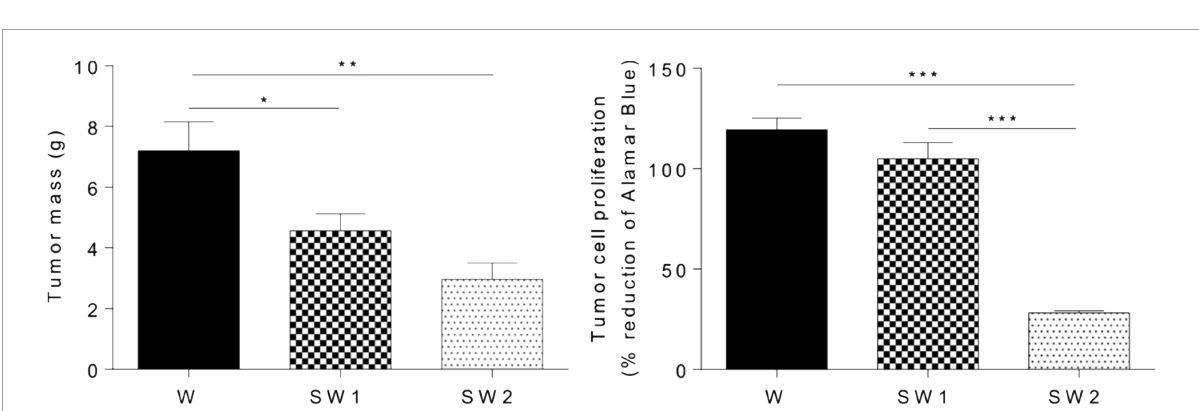
FIGURE15 Effect of latex treatment on tumor mass and tumor cell proliferation in untreated animals with tumor (W), animals with tumor treated with 25 µ L/mL aqueous solution of latex (SW1), and animals with tumor treated with 50 µ L/mL aqueous solution of latex at (SW2). Data are presented as the mean + SEM. W, n = 11; SW1, n = 12; SW2, n = 14. * p < 0.05, ** p < 0.001, and *** p < 0.0001 (one-way ANOVA followed by a post-hoc Tukey test) (Martins et al., 2020).